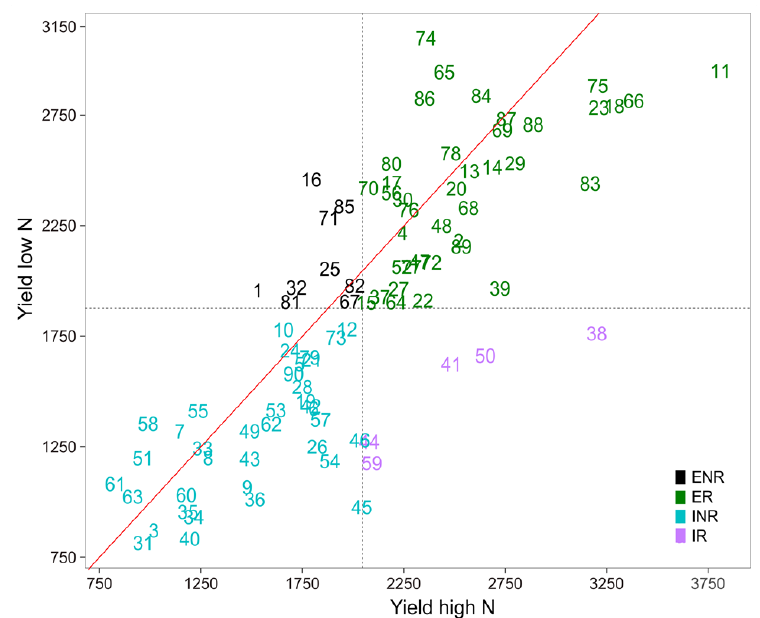
Figure 3. Performance in relation to the nitrogen use efficiency and responsiveness to nitrogen fertilization in 90 popcorn hybrids evaluated in Campos dos Goytacazes, RJ. ER: efficient and responsive; ENR: efficient and nonresponsive; IR: inefficient and responsive; and INR: inefficient and nonresponsive.